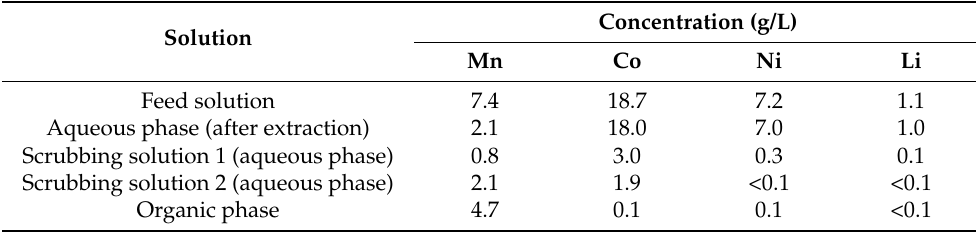
Table 5. Composition of the scrubbing solutions and the resultant organic phase after two scrubbing stages with 4 g/L Mn (O:A of 10:1, contact time of 10 min). Solution